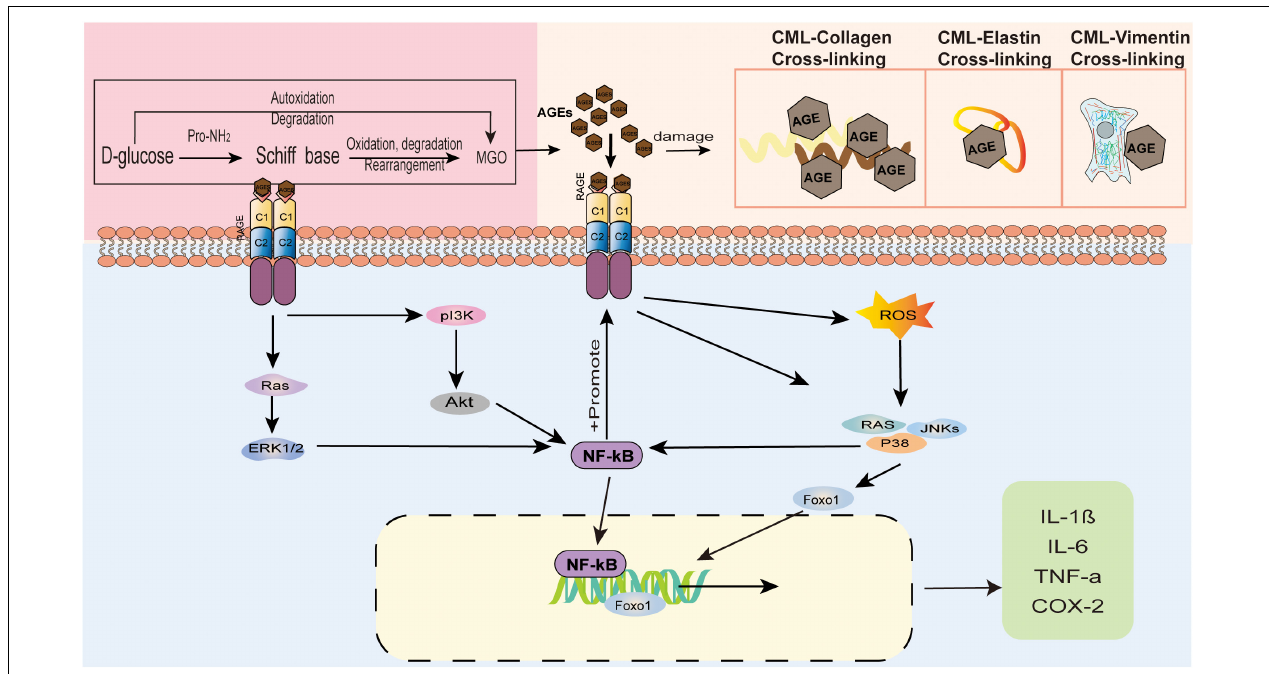
FIGURE 4 | The effect of AGEs on the dermis of the skin. AGEs and collagen are cross-linked, causing the protein to brown and the fibers to deform. Elastin fiber becomes thinner, less rigid, and loses its biological properties. Glycosylated vimentin leads to the loss of fibroblasts’ contraction ability and the inability to maintain the basic cell shape. AGEs bind to RAGE receptors to regulate gene expression and mediate a series of signal